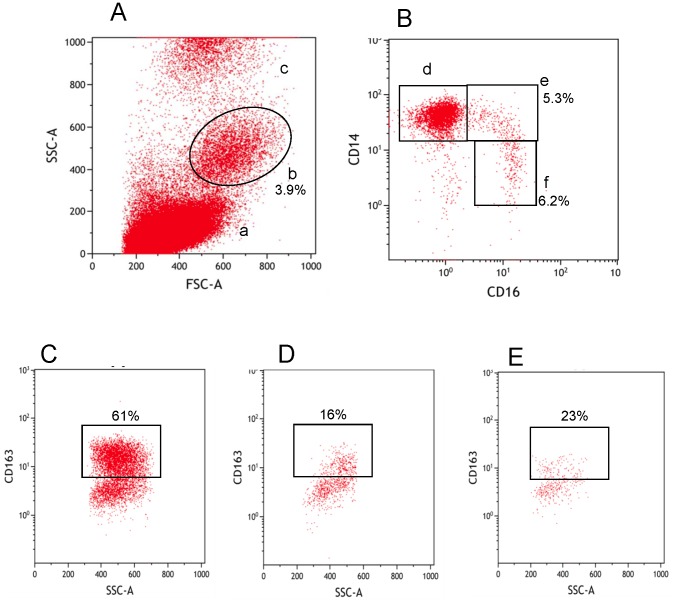
Phenotypic identification of monocytes and monocyte subsets.Whole blood monocytes were identified by a forward scatter and side scatter plot (A). Lymphocytes (a), monocytes (b) and the granulocytes (c) are shown. The three monocyte subsets were identified from the monocyte population (b) by CD14 and CD16 expression (B). Classical monocytes (d-CD14++/CD16-), intermediate monocytes (e-CD14++/CD16+) and non-classical monocytes (f-CD14+/CD16+) were gated for further analysis of activation markers. For example figures C, D and E show CD163 expression from d, e and f respectively.